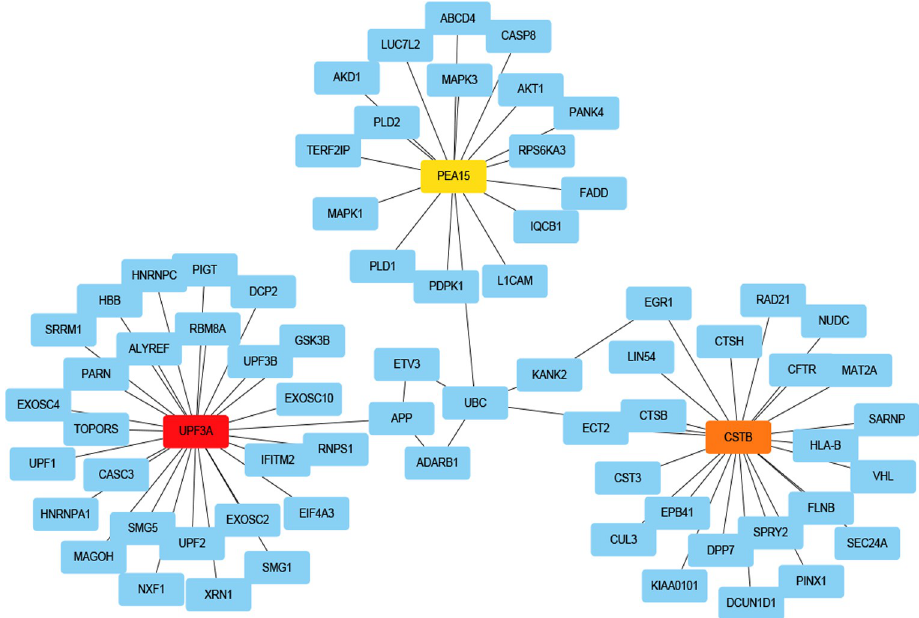
Fig 5. Identification of hub genes from PPI network.